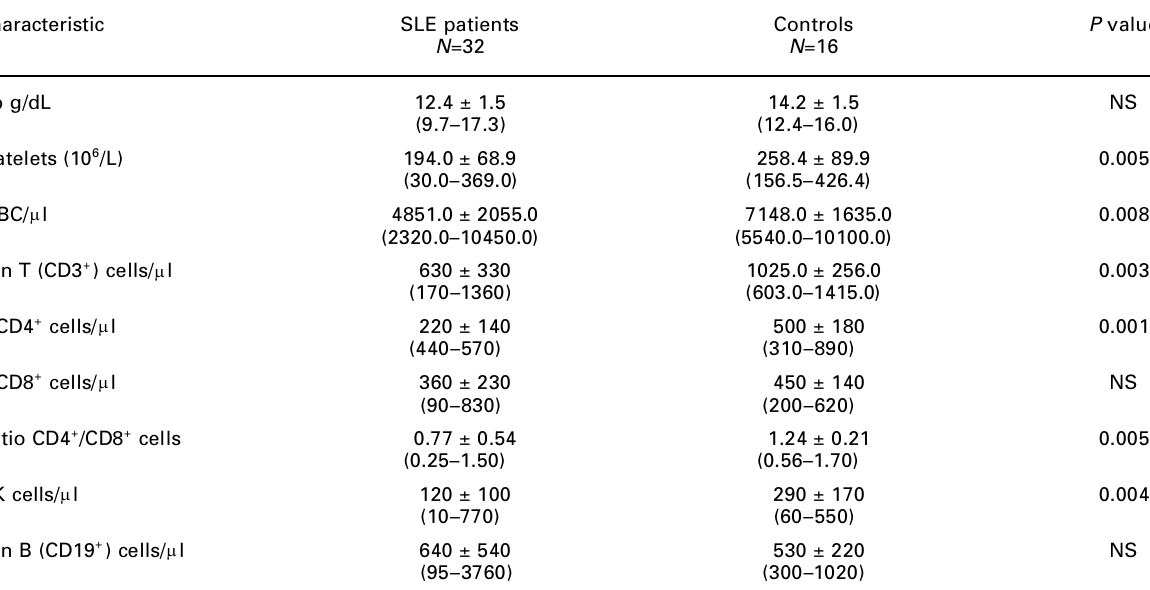
Table 2. Characteristics of peripheral blood parameters in SLE patients and healthy donors (mean values ± SD and range in parentheses) Characteristic SLE